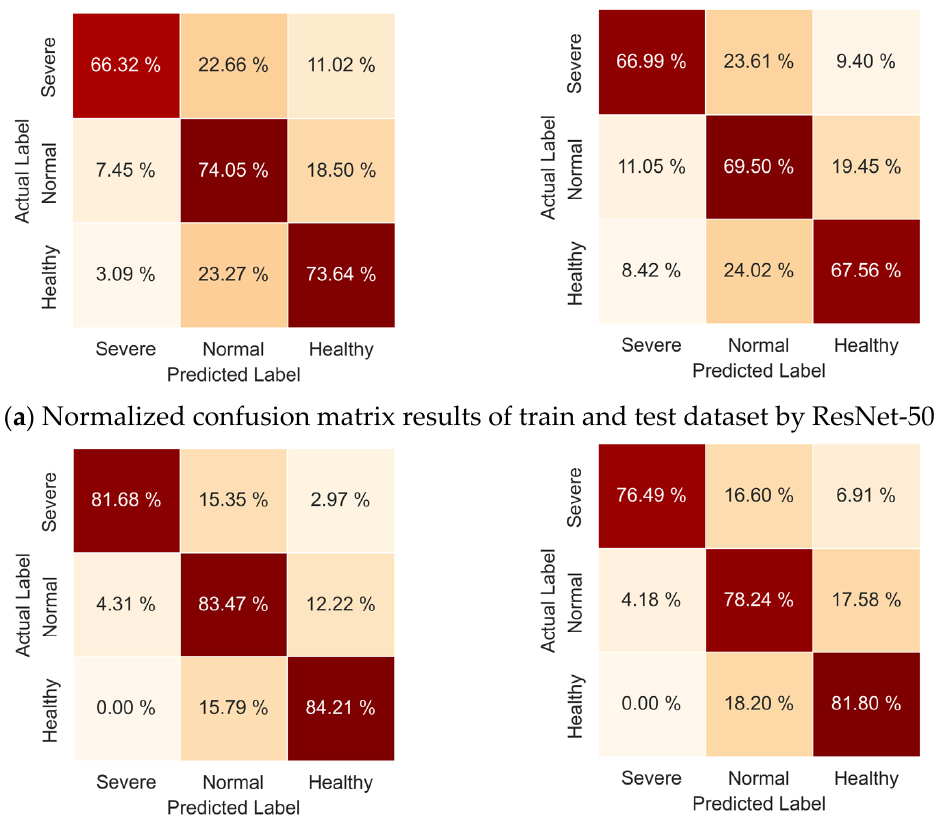
Figure 5. Confusion matrix results of hair follicle classification: ResNet-50 training dataset in ( a )-left, ResNet-50 test dataset in ( a )-right, ResNet-101 training dataset in ( b )-left, and ResNet-101 test dataset in ( b )-right.